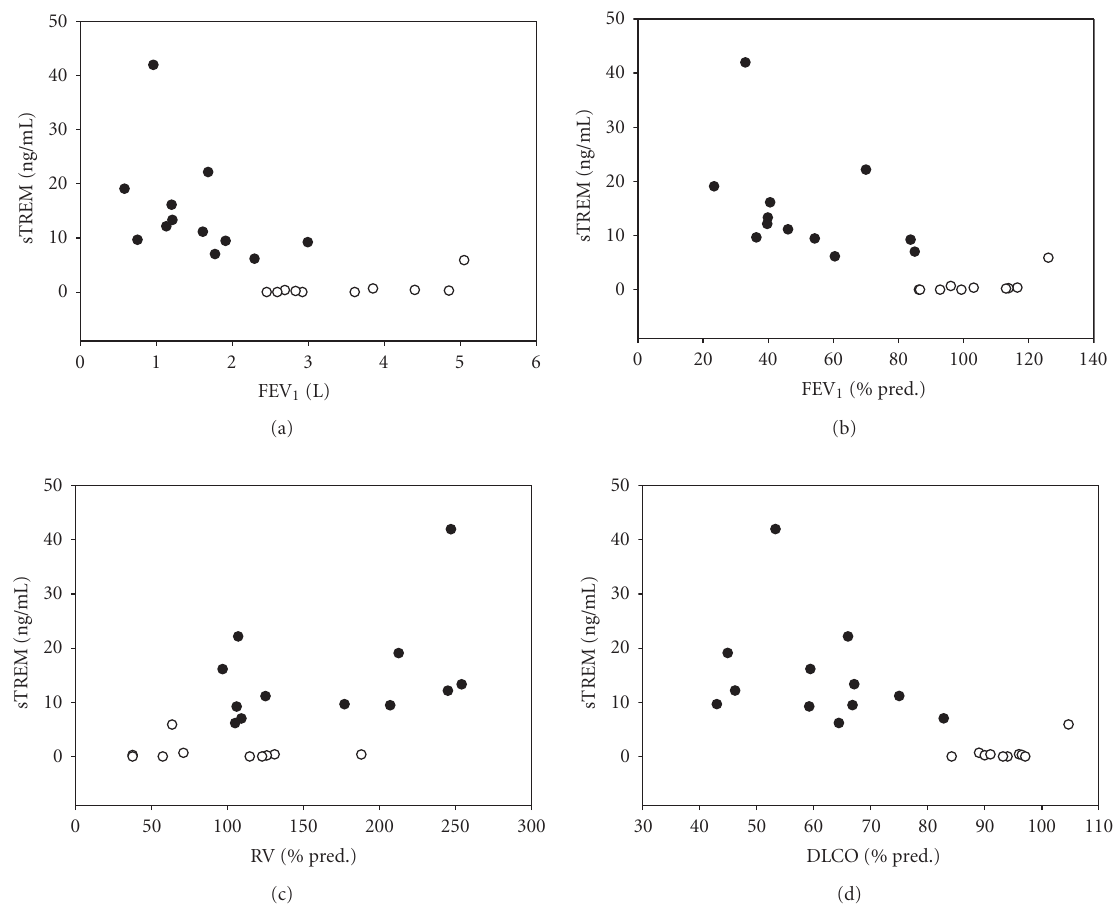
Figure 3: Relationship between sTREM-1 serum levels and absolute FEV 1 (panel A), FEV 1 % predicted (panel B), residual volume (RV) % predicted (panel C), and di ff usion capacity (DLCO) % predicted (panel D). Control subjects are represented by open circles, patients with COPD by closed